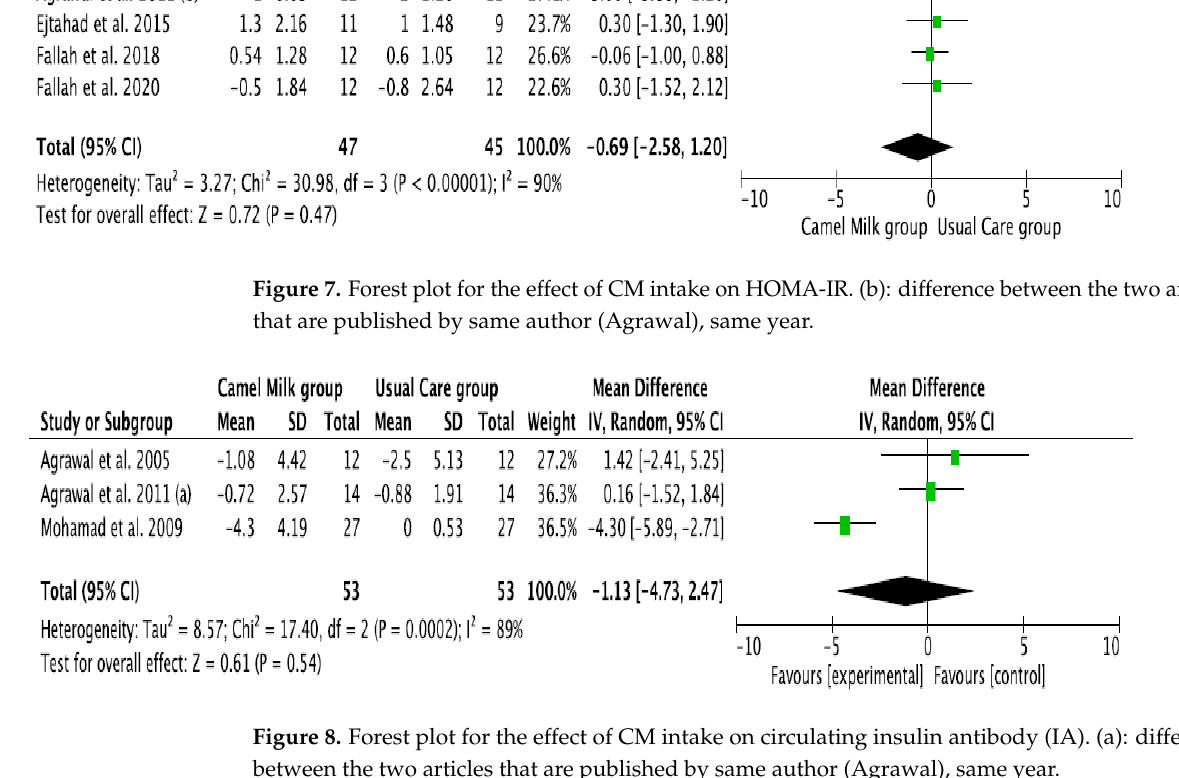
between the two articles that are published by same author (Agrawal), same year. Figure 8. Forest plot for the effect of CM intake on circulating insulin antibody (IA). (a): difference